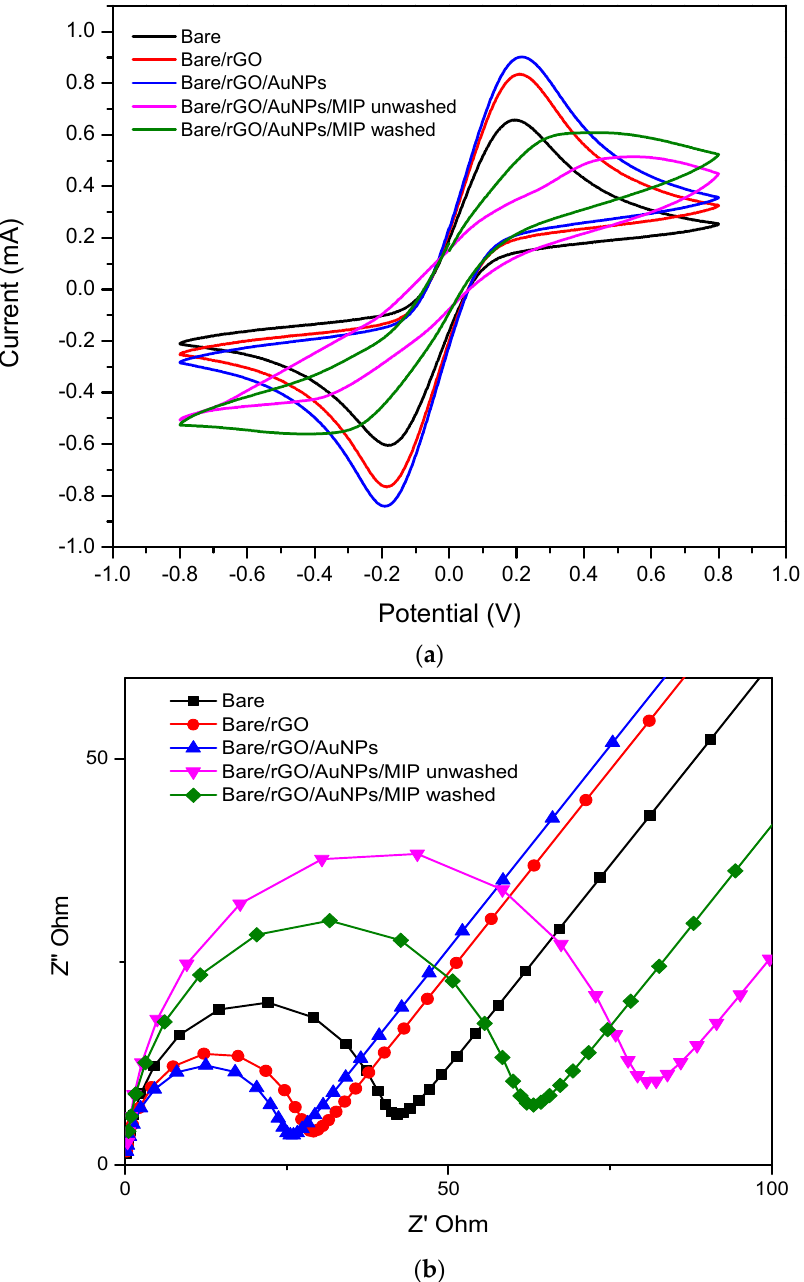
Figure 6. ( a ) Electrochemical response studies via the CV technique for Bare SPE (black), rGO@SPE (red), AuNPs/rGO@SPE (blue), MIP unwashed/AuNPs/rGO@SPE (green), and MIP washed/AuNPs/rGO@SPE (magenta) obtained in the presence of [Fe(CN) 6 ] 3 − /4 − electrolyte at 50 mV/s. ( b ) The EIS study of Bare SPE (black), rGO@SPE (red), AuNPs/rGO@SPE (blue), MIP un- washed/AuNPs/rGO@SPE (magenta), and MIP washed/AuNPs/rGO@SPE (green) at the frequency range of 10–2000 Hz.